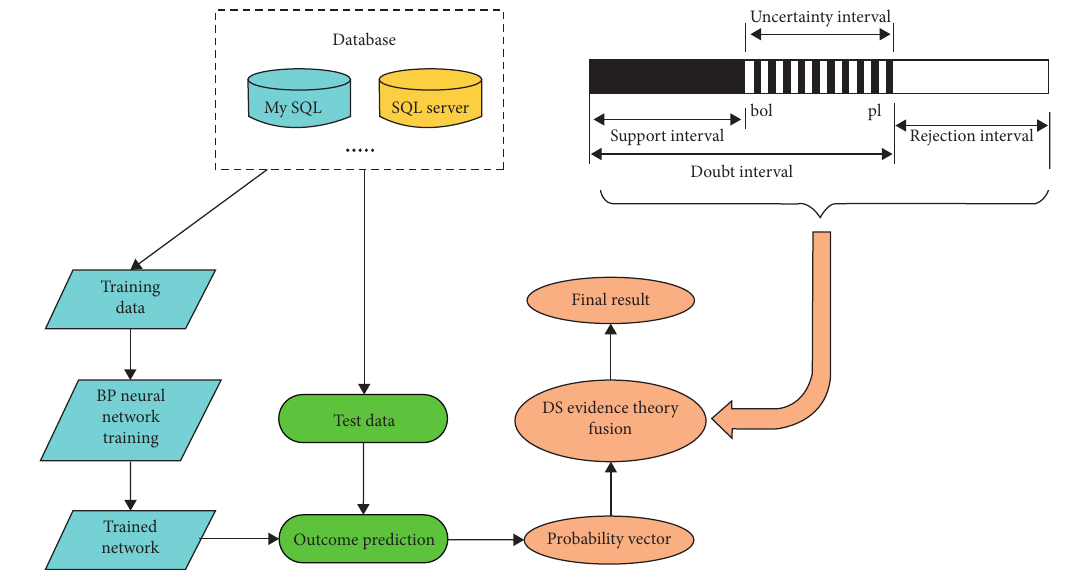
Figure 4: DSBP prediction model